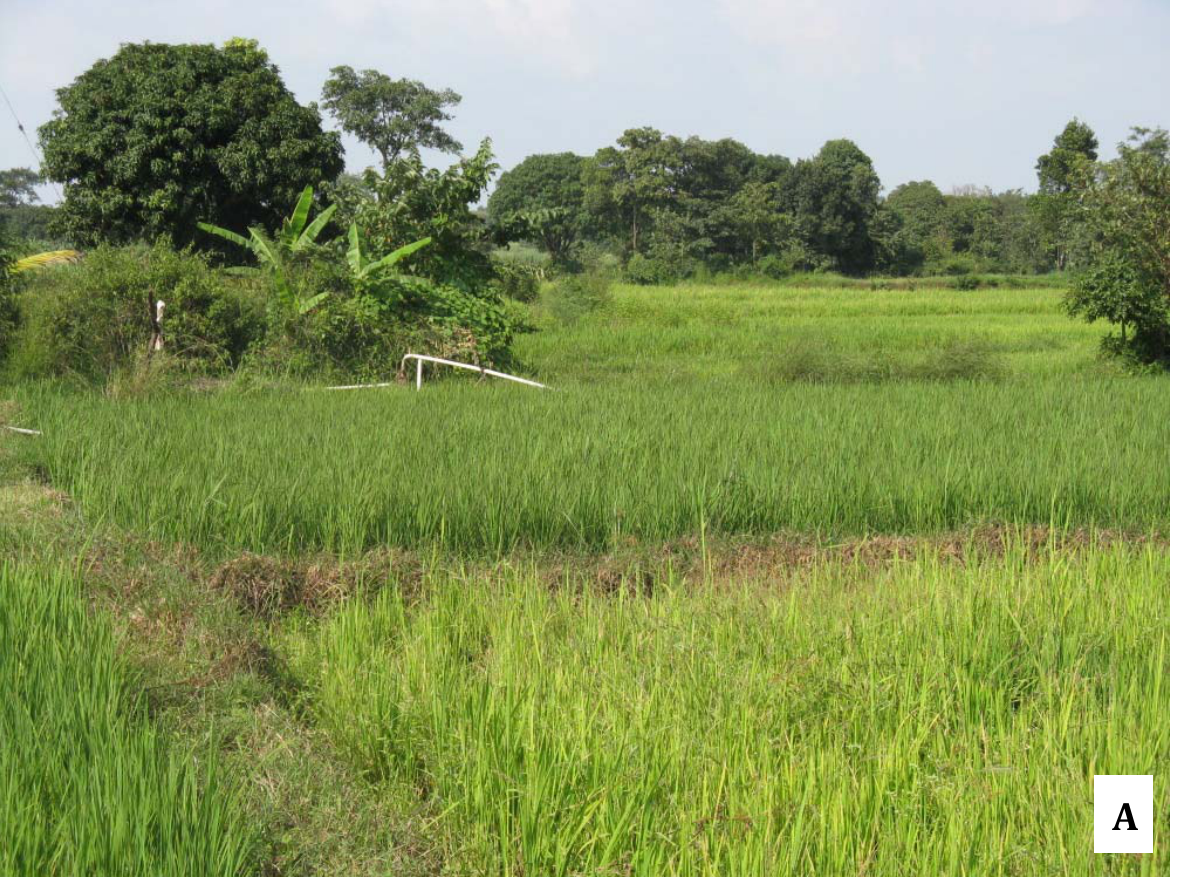
Figure 1. Near ground photographs of irrigation practices in three different irrigated locations. (A) Irrigated rice paddies with a bore well in the background in north-central India. The complex nature of this landscape with multiple land cover types surrounding irrigated fields illustrates the need for high spatial resolution data which may come at a cost of frequency of observations needed to map paddy fields. Image is provided courtesy of Eby Heller from McGill University. (B) A large irrigated alfalfa field in Utah (USA) and a rotating drum irrigation system. In these types of environments, the spatial requirements for irrigation mapping can be relaxed but the spectral properties of the image signal must be enhanced to distinguish irrigation. Photo courtesy of USDA NRCS. (C) A large irrigated landscape interspersed with multiple land cover types in Idaho (USA). This photograph illustrates the fact that even though many landscapes may be heterogeneous, the size of individual landscape elements (e.g., cultivated fields) determines the spatial resolution requirements of an irrigation mapping exercise. Photo courtesy of USDA